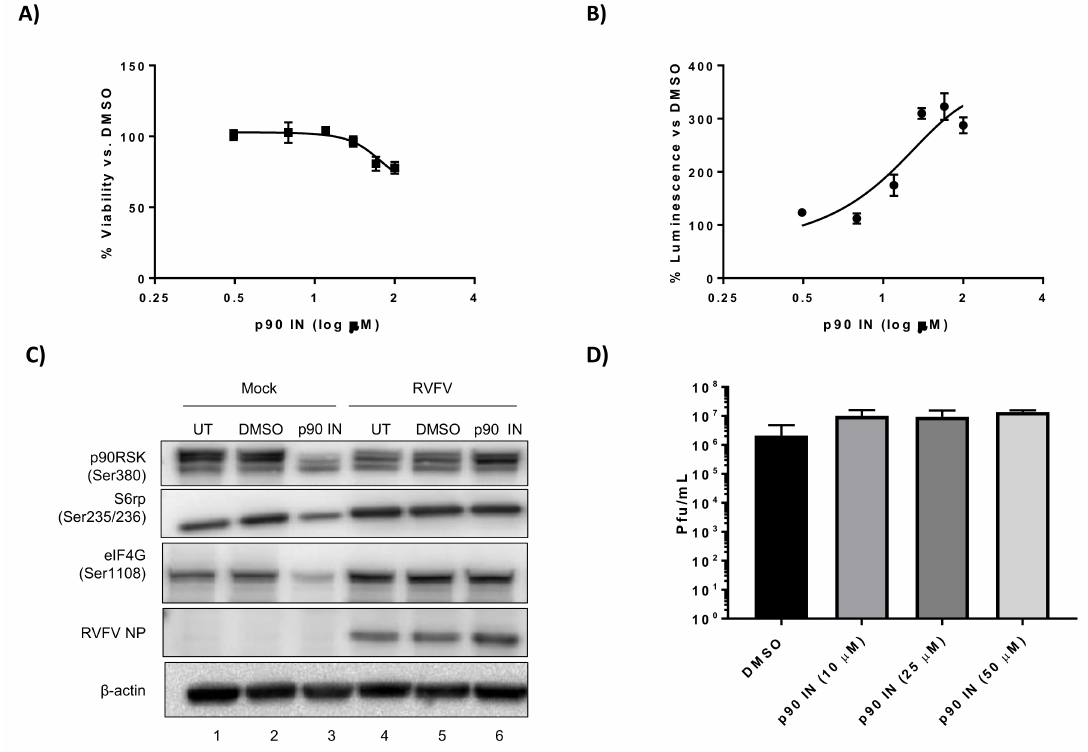
Figure 2. BI-D1870, a p90RSK inhibitor, increases RVFV replication. ( A ) H2.35 cells were treated with BI-D1870 p90RSK inhibitor (p90 IN) and cell viability analyzed at 24 h using Cell Titer-Glo. Percent viability was calculated relative to the DMSO control. The mean and SD (N = 3) are plotted; ( B ) H2.35 cells were pre-treated for 1 h, followed by a 1 h infection with RVFV MP12 ∆ NSs-Luc (MOI